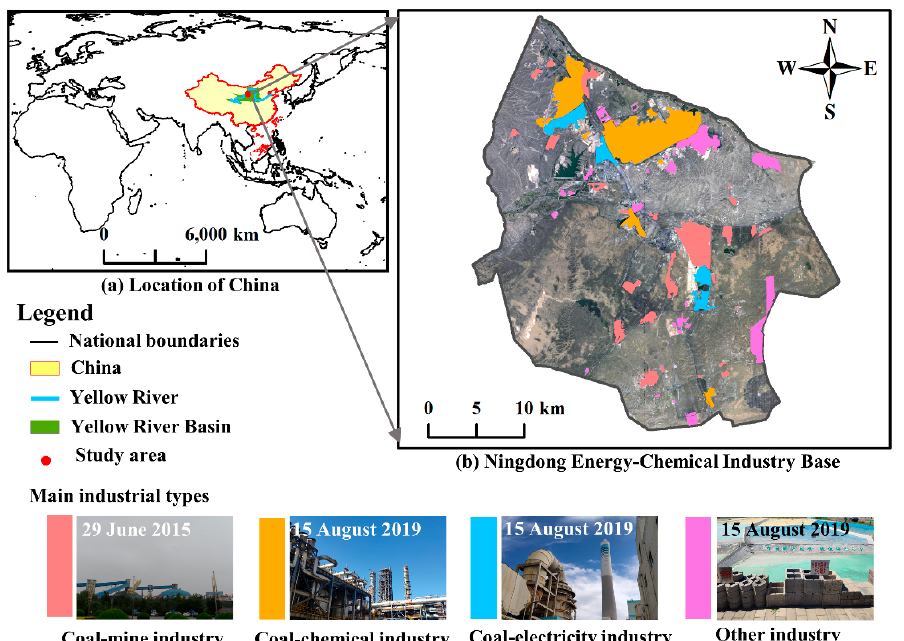
Figure 1. ( a , b ) Location of the study area and the main industrial